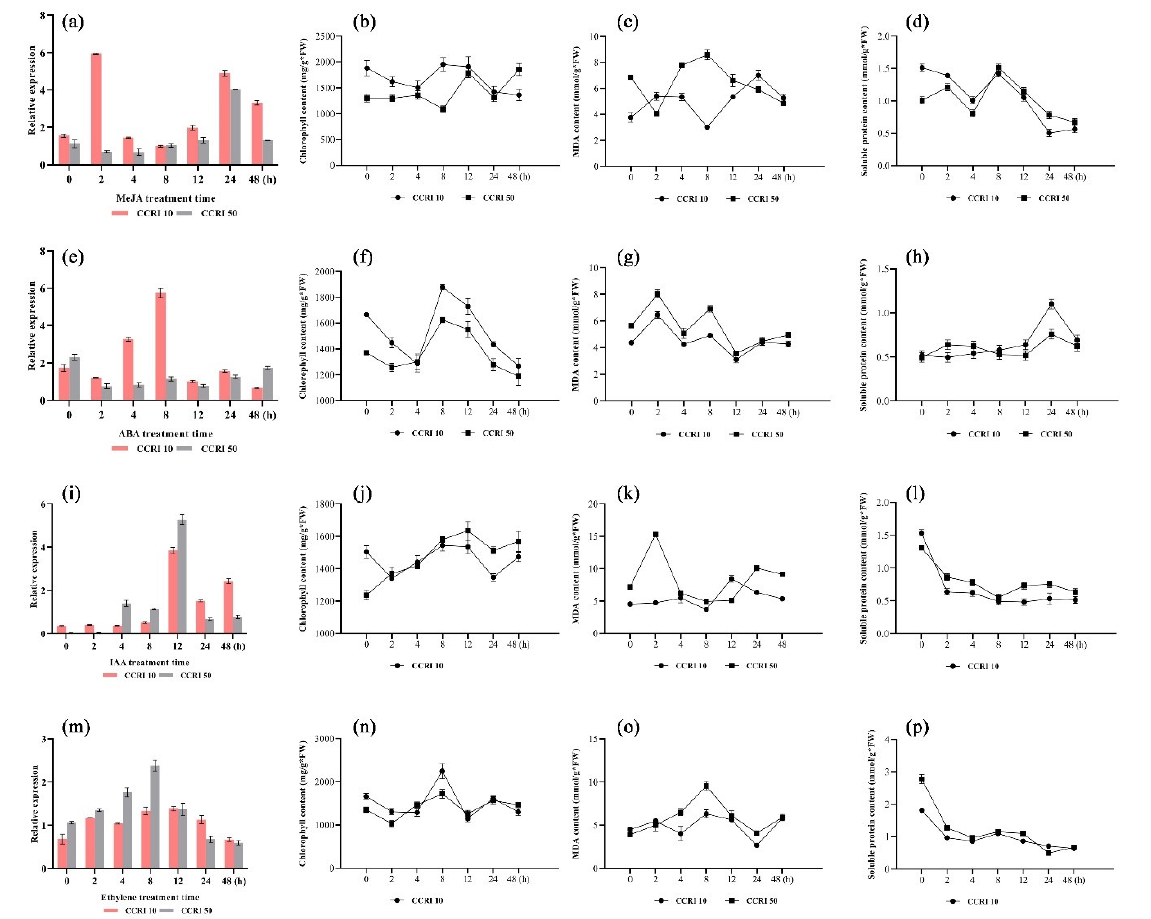
Figure 6. Expression patterns and physiological indicators of GhNAC82 in response to phytohormone treatments. ( a , e , i , m ) Expression pattern of GhNAC82 under treatment with auxin, abscisic acid, ethylene and methyl jasmonate; ( b , f , j,n ) Changes of chlorophyll content under phytohormone treatments; ( c , g , k,o ) Changes of malondialdehyde content under phytohormone treatments; ( d , h , l,p ) Changes of soluble protein content under phytohormone treatments.